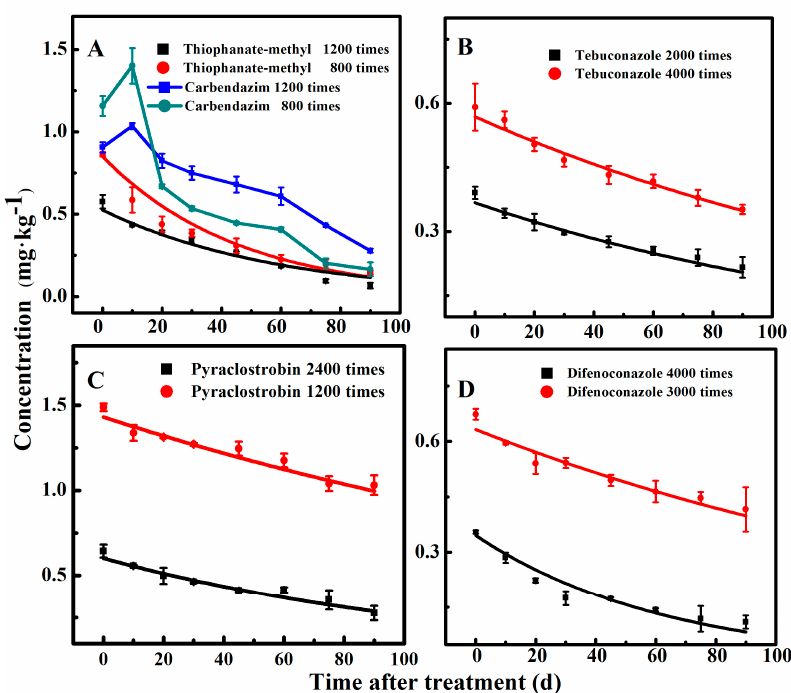
Figure 4. Dissipation dynamics of thiophanate-methyl and carbendazim ( A ), tebuconazole ( B ), pyraclostrobin ( C ), and difenoconazole ( D ) in pears at 4 °C.